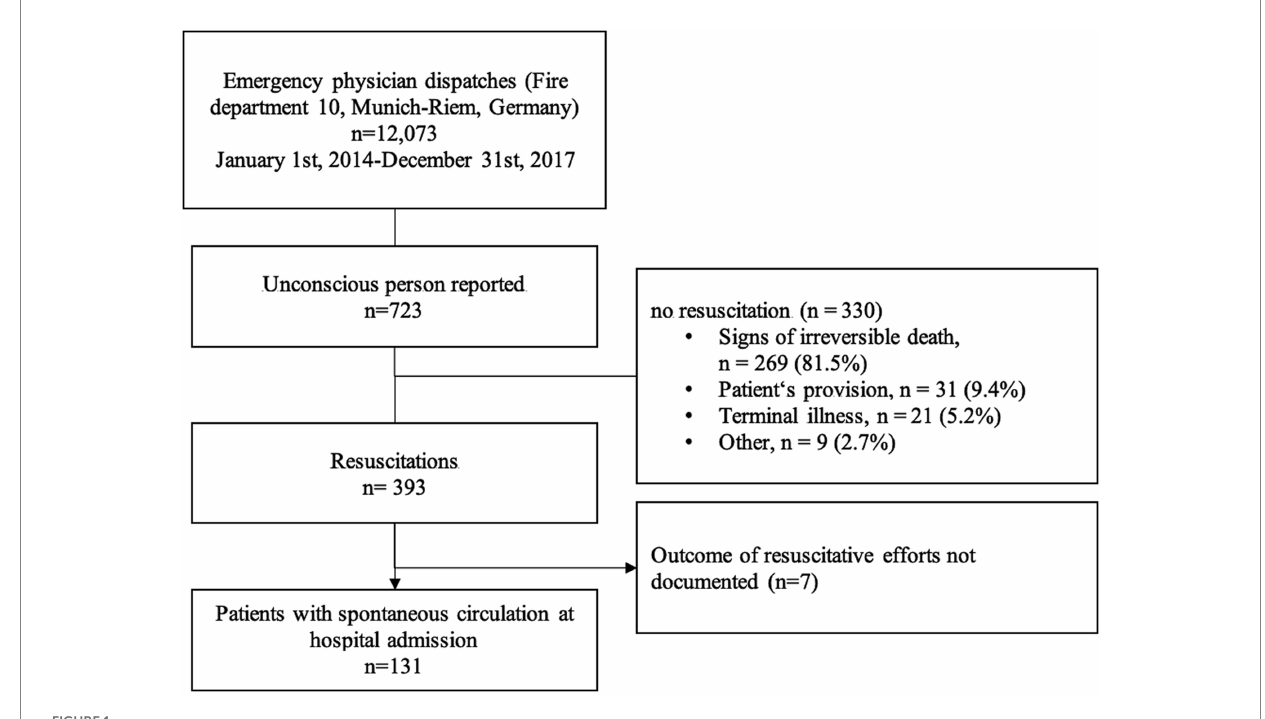
FIGURE 1 CONSORT flow